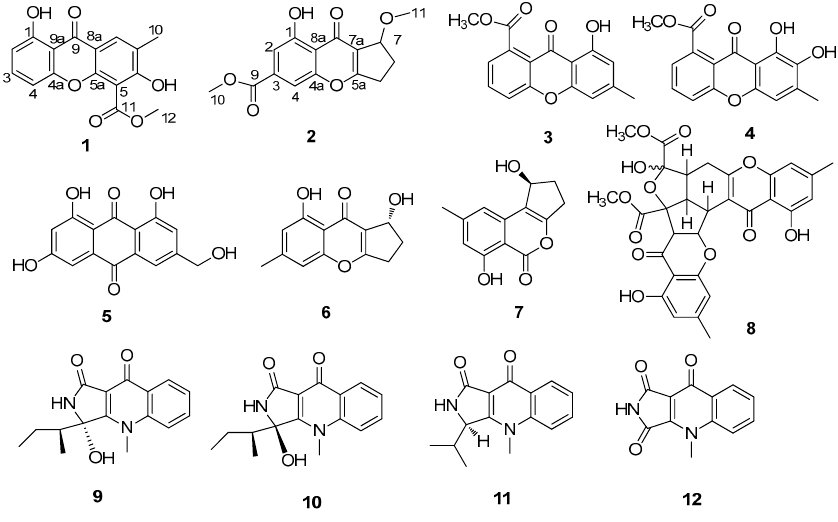
Figure 1. Structures of metabolites 1 – 12 .